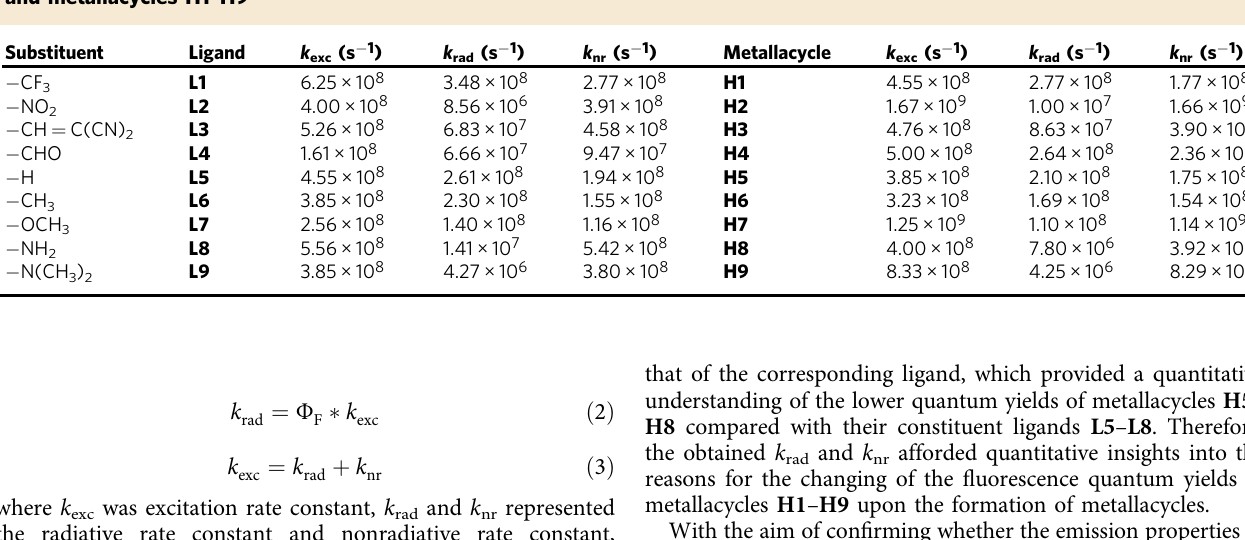
Fig. 5 Fluorescence titration spectra of ligands L3 , L4 , L7 , and L9 . Fluorescence spectra of ligands L3 a , L4 b , L7 c , and L9 d upon the addition of mono-Pt (II) ligand 10 in dichloromethane Table 2 Excitation rate constants ( k exc ), radiative rate constants ( k rad ), and nonradiative rate constants ( k nr ) for ligands L1 – L9 and metallacycles H1 –